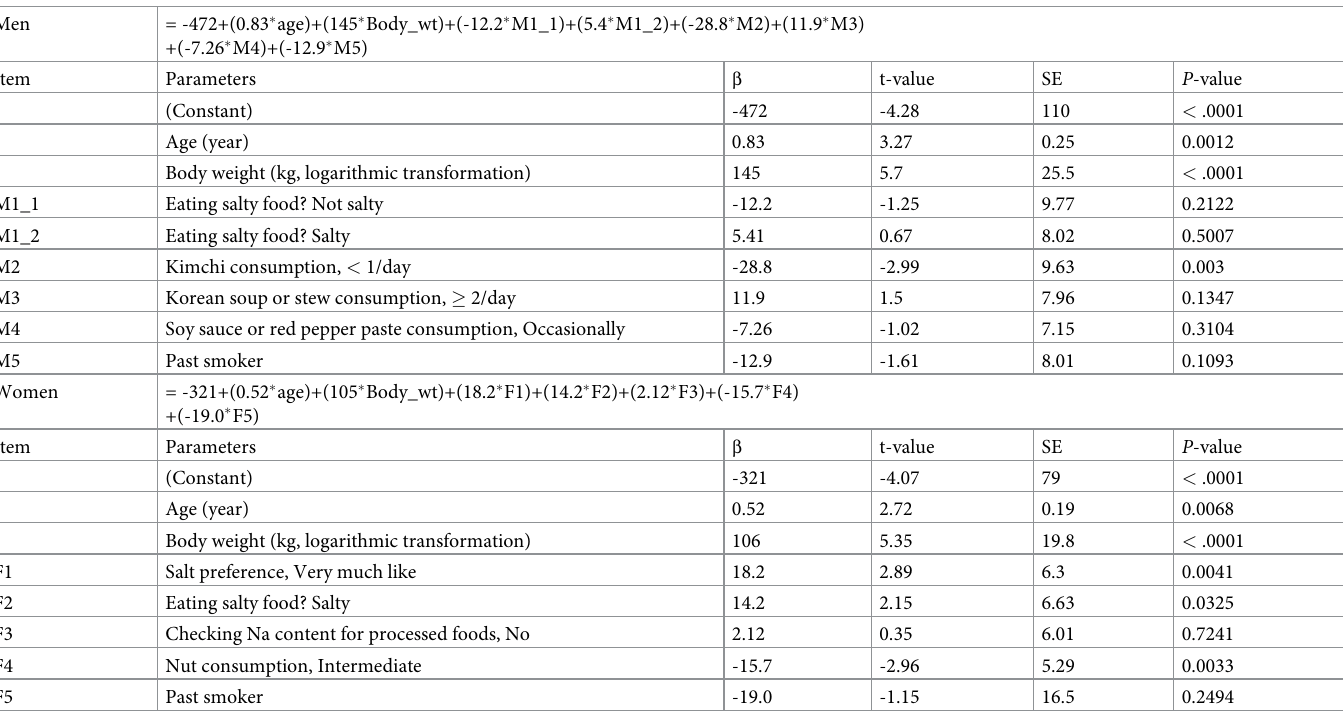
Table 2. Equation for estimation of 24-hUNa (mmol/d), using β -coefficient estimates in multiple linear regression. Men = -472+(0.83 (cid:3) age)+(145 (cid:3) Body_wt)+(-12.2 (cid:3) M1_1)+(5.4 (cid:3) M1_2)+(-28.8 (cid:3) M2)+(11.9 (cid:3) M3) +(-7.26 (cid:3) M4)+(-12.9 (cid:3)